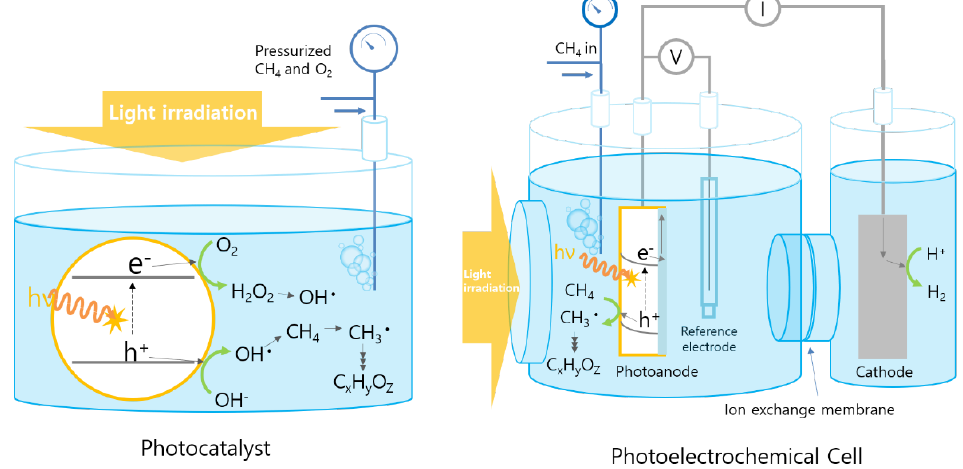
Figure 6. Comparison of the methane oxidation mechanisms of the photocatalyst and photoelectro chemical cell